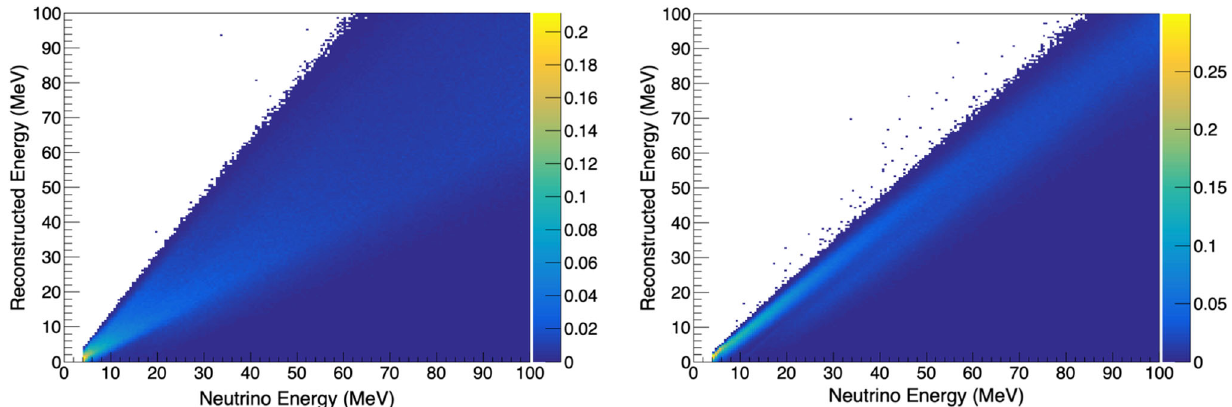
Fig. 8 Left:transfermatrixfor SNOwGLoBES createdwithmonoen- ergetic ν e CC MARLEY samples run though LArSoft, with the color scale indicating the relative detected charge distribution as a function of neutrino energy. The effects of interaction product distributions and detectorsmearingarebothincorporatedinthistransfermatrix.Theright